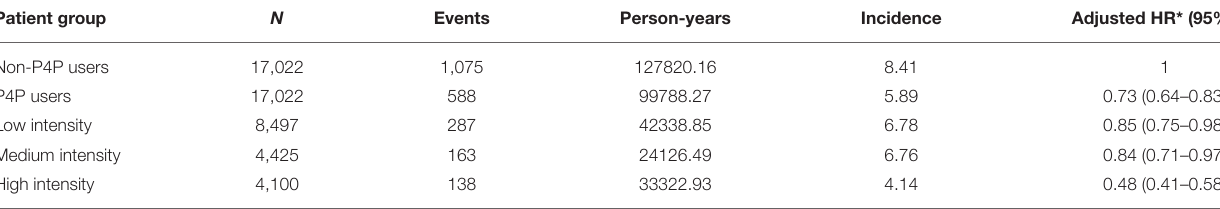
TABLE 2 | Risk of depression for T2DM patients with and with no use of P4P program. Patient group